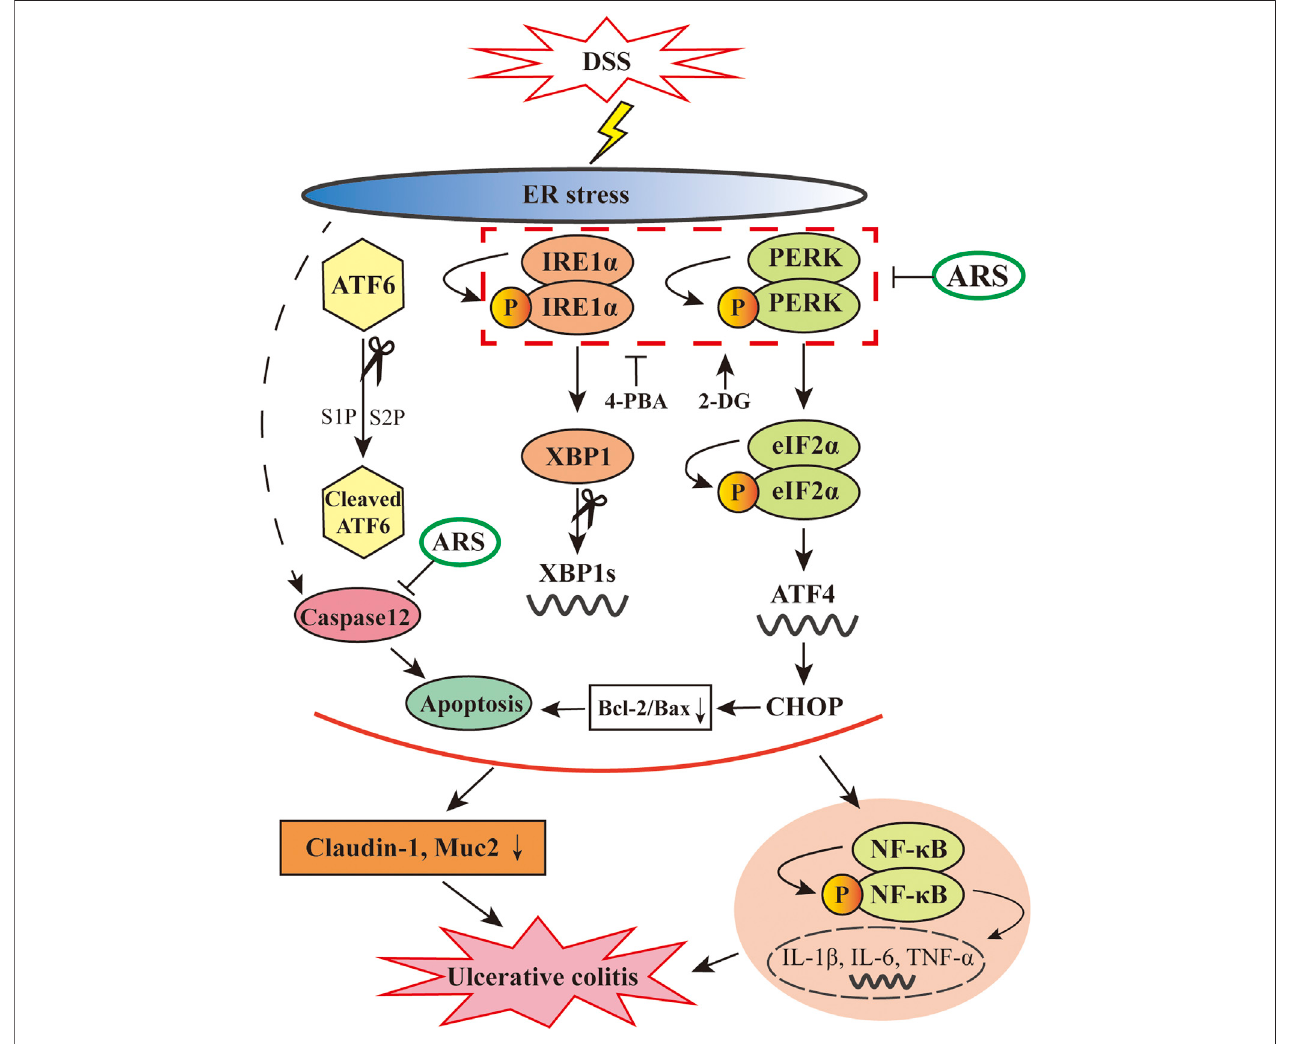
FIGURE 8 | Diagram showing the proposed pathways suppressed by ARS in the colonic tissues of murine UC model induced by DSS. ARS signi fi cantly inhibited DSS induced excessive ER stress via suppressing PERK-eIF2 α -ATF4-CHOP and IRE1 α -XBP1 signaling pathways with the consequent ER stress-associated apoptosis. The relieved effect of ARS on excessive ER stress plays critical role in downregulating the activation of NF- κ B and the mRNA expression levels of pro-in fl ammatory cytokines as well as maintained the expression of claudin-1 and Muc2.